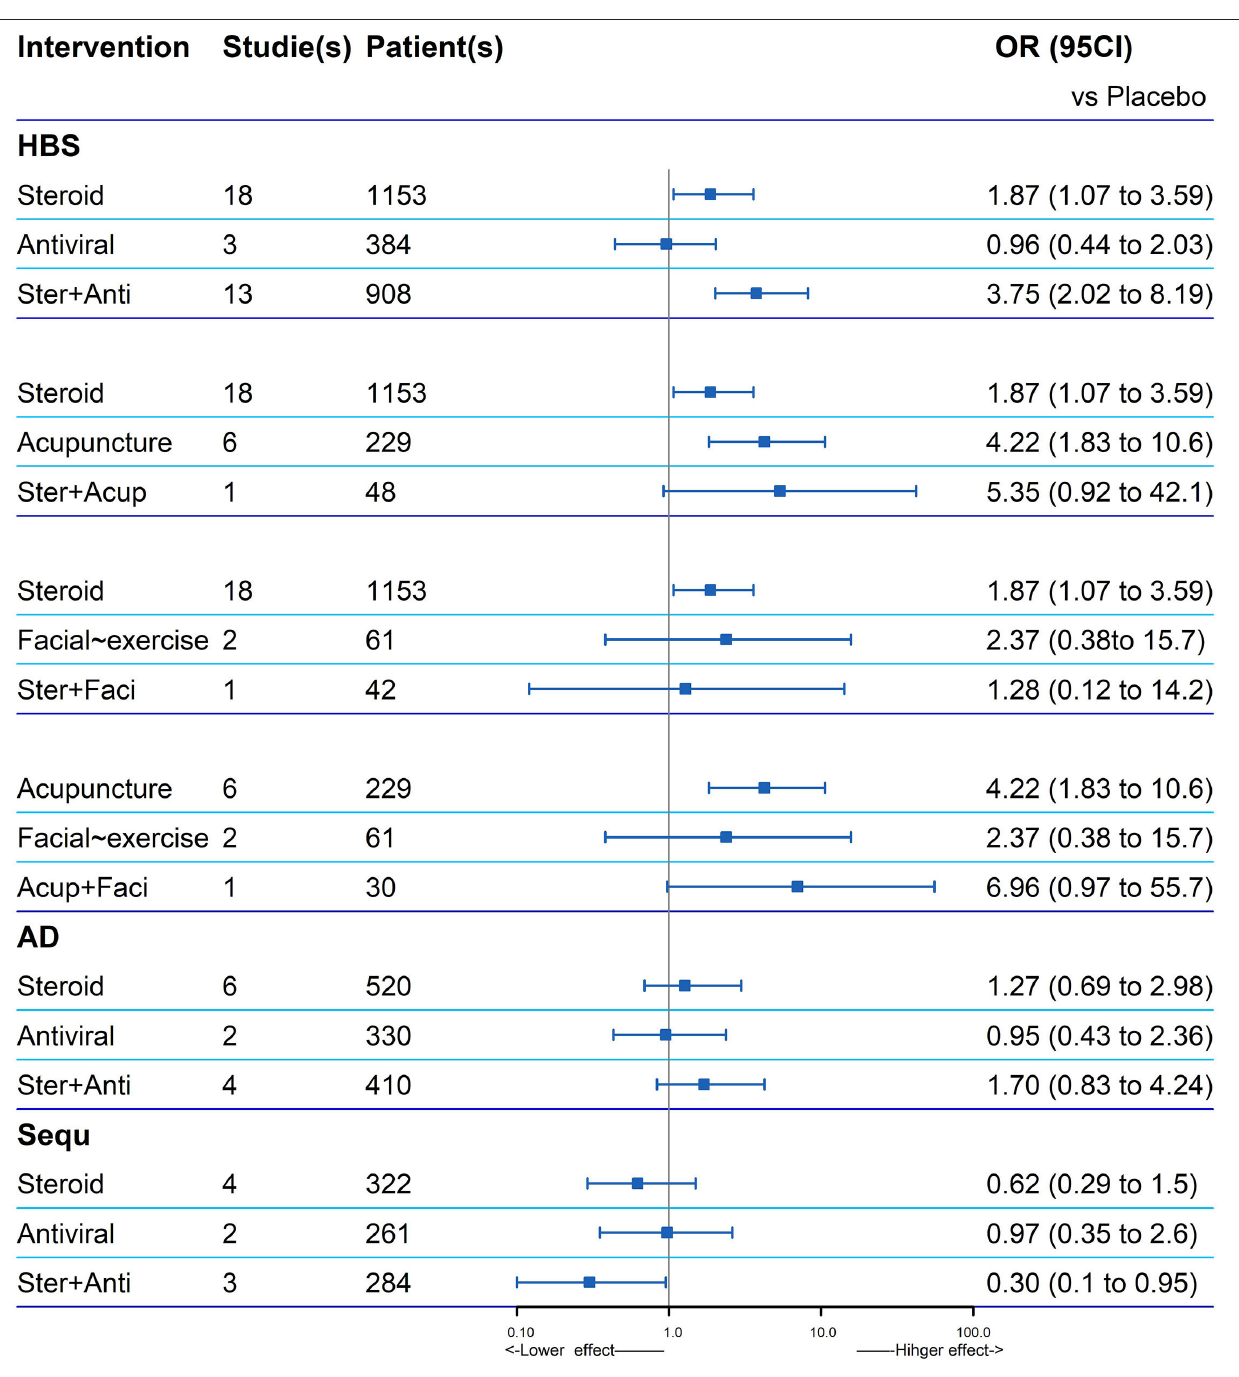
and 42%). However, a single antiviral drug seemed to be less